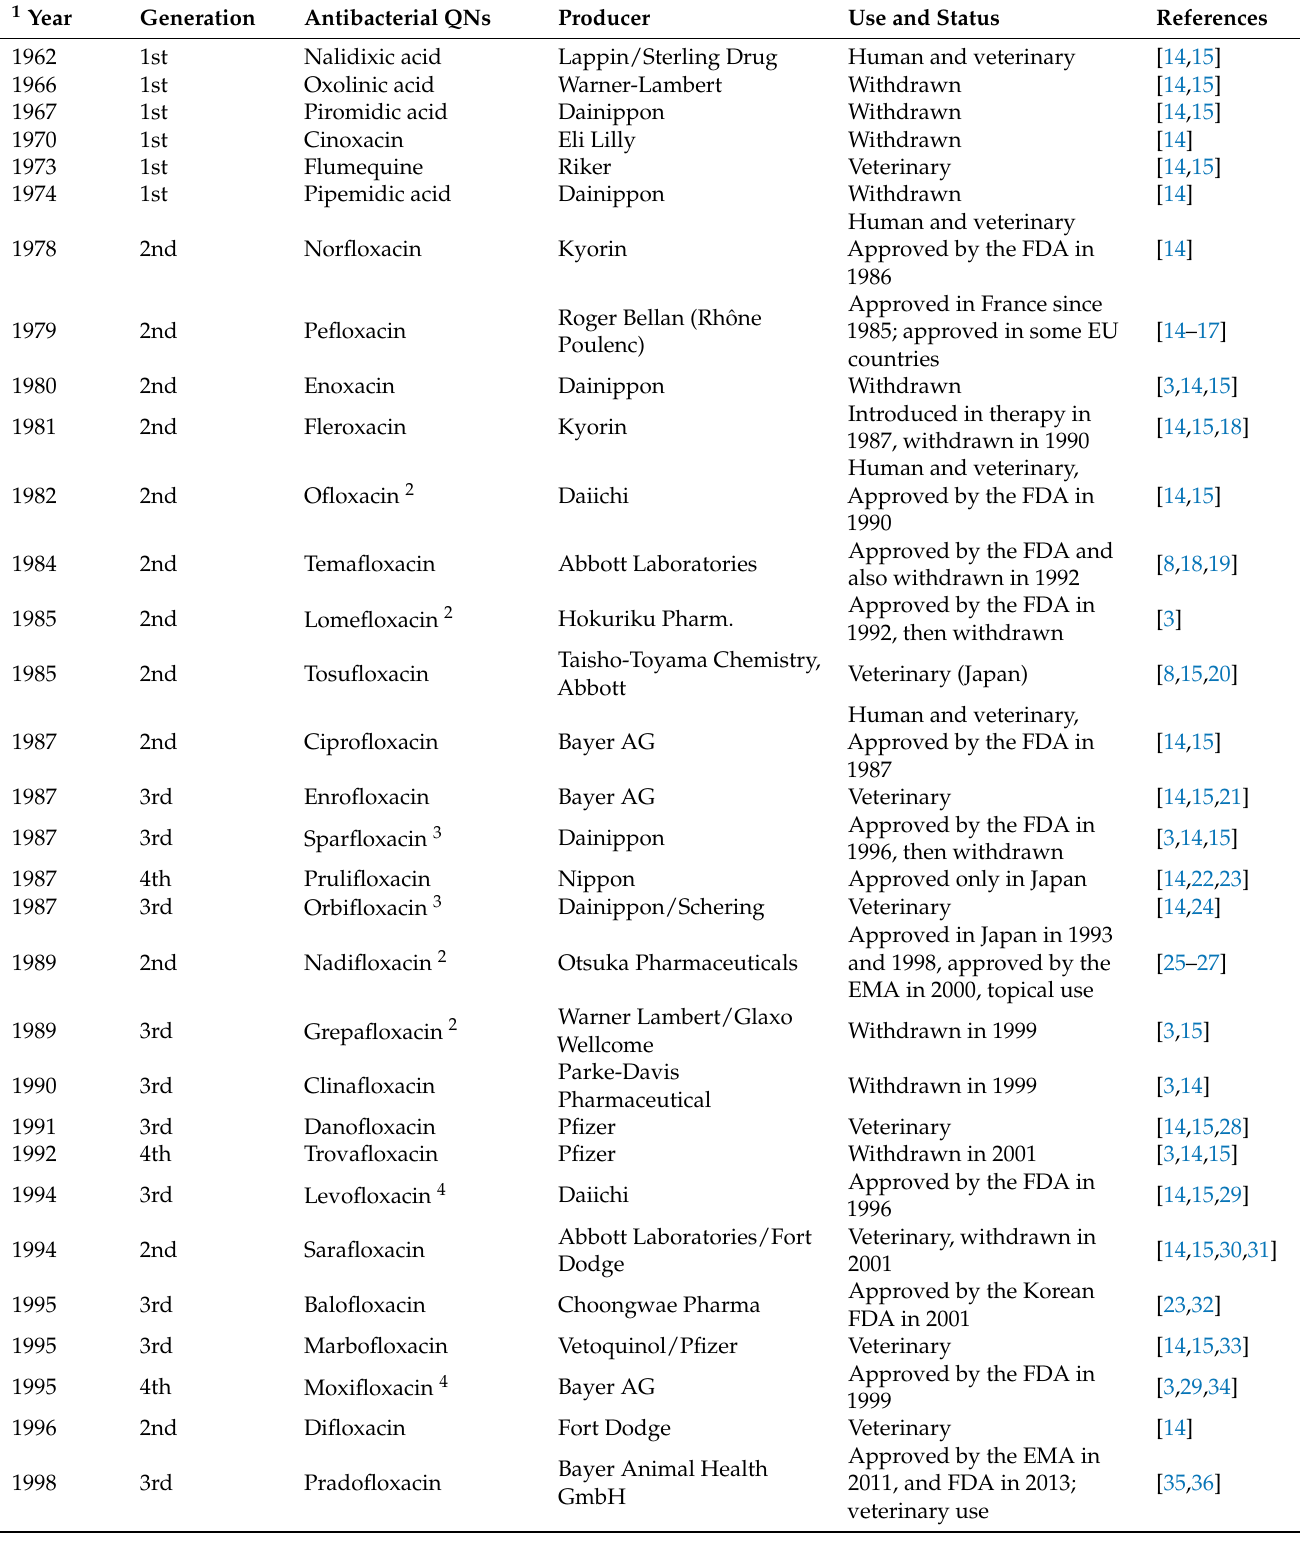
Table 1. The representatives of the class of antibacterial QNs and their approval in